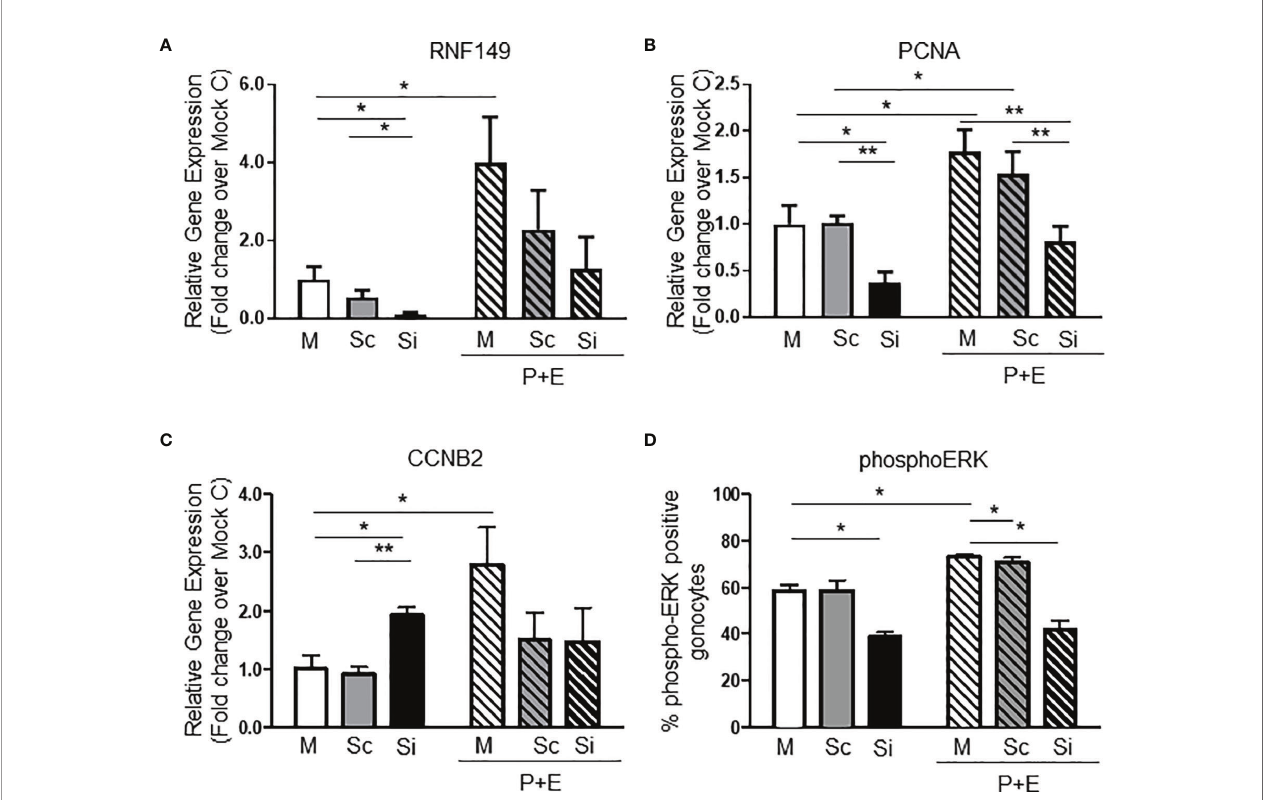
FIGURE 2 | RNF149 knockdown in PND3 gonocytes. (A) RNF149 mRNA expression in gonocytes fi rst treated with mock (M), scrambled siRNA (Sc), or RNF149 siRNA (Si) for 48 hours and then treated with or without PDGF-BB (10 -9 M) and 17 b -estradiol (10 -6 M) [with 2.5% fetal bovine serum (FBS)] for an additional 24 hours. Results shown are from N=3-5 independent germ cell preparations (each done in duplicate) and are plotted mean ± SEM. *p-value<0.05. (B) PCNA mRNA expression and (C) CCNB2 mRNA expression in similarly treated cells. **p-value<0.01. (D) Treated gonocytes were immunostained using phospho-ERK antibody. Total number of gonocytes and positively stained cells were counted. Percentage of phospho-ERK-positive cells was graphed. Results shown are from N=3 independent germ cell preparations.